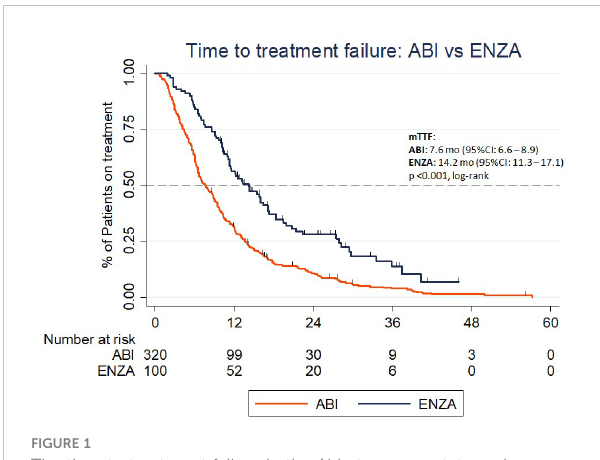
FIGURE 1 The time to treatment failure in the Abiraterone acetate and Enzalutamide